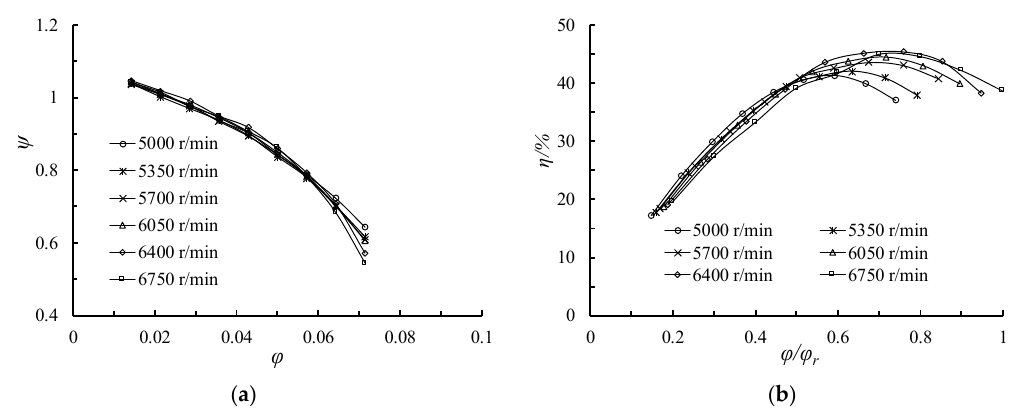
Figure 8. Pump performance curves at different rotational speed: ( a ) dimensionless head curve; ( b ) pump efficiency curves.